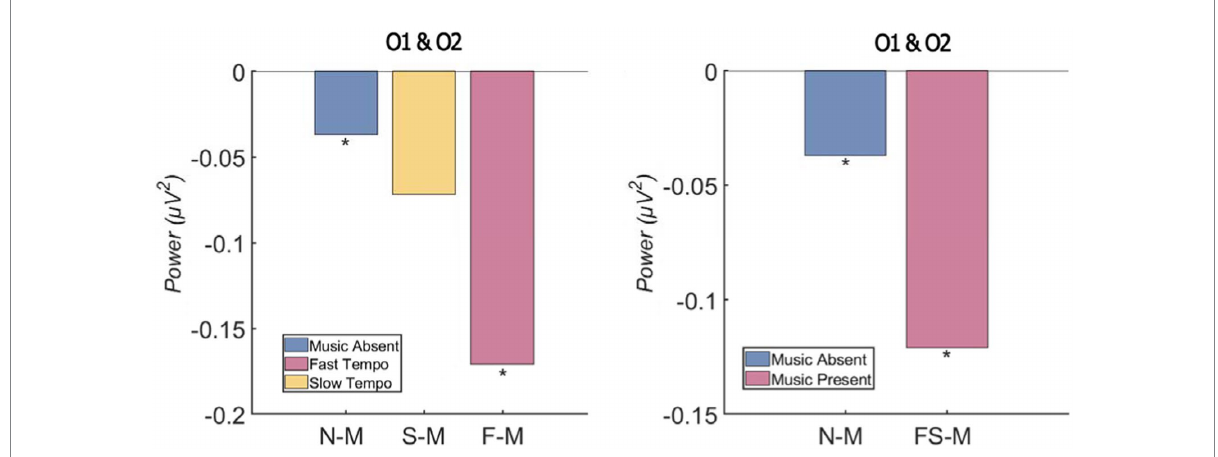
FIGURE 2 Alpha-rhythm suppression level by condition (*denotes a statistically significant